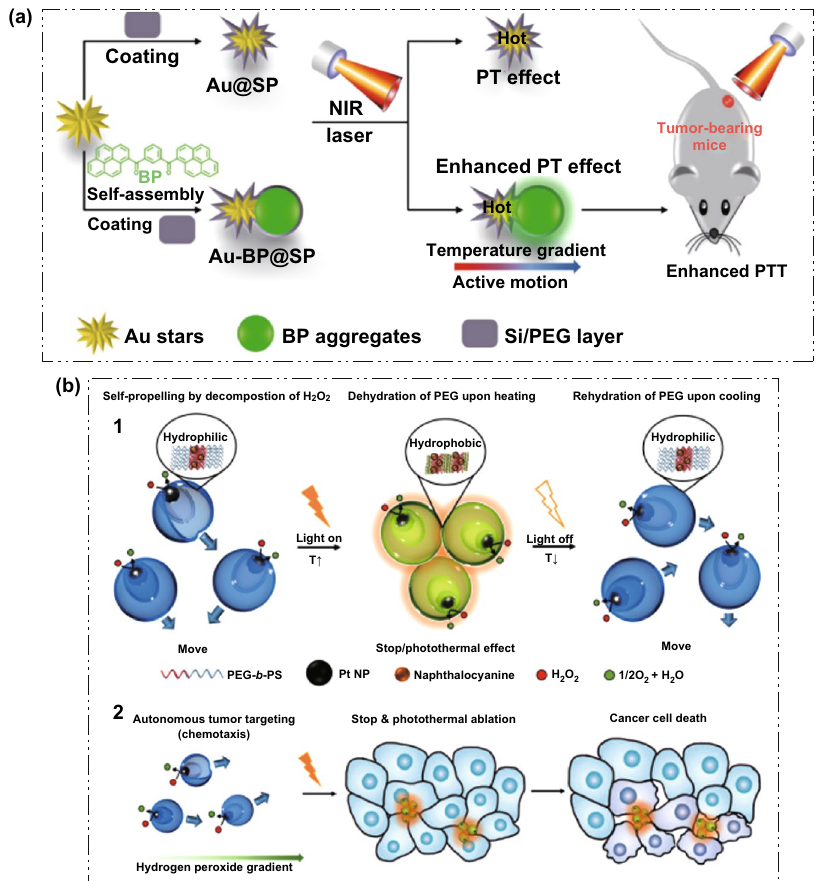
Fig. 9 a Schematic illustration of a self-propulsion Au-BP@SP Janus nanoparticle for cancer cell treatment under NIR laser irradiation. Adapted from Ref. [103] with permission, copyright Wiley Ltd., 2016. b Light-guided nanomotor systems for autonomous photothermal cancer therapy. (1) Schematic representation of a light-guided nanomotor system using PEG44-b-PS141/naphthalocyanine (NC) and Pt nanoparticles (Pt NPs) powered by the conversion of hydrogen peroxide (H 2 O 2 ). (2) Schematic illustration for the autonomous photothermal ablation of cancer cells using the nanomotors. Adapted from Ref. [104] with permission, copyright American Chemical Society,